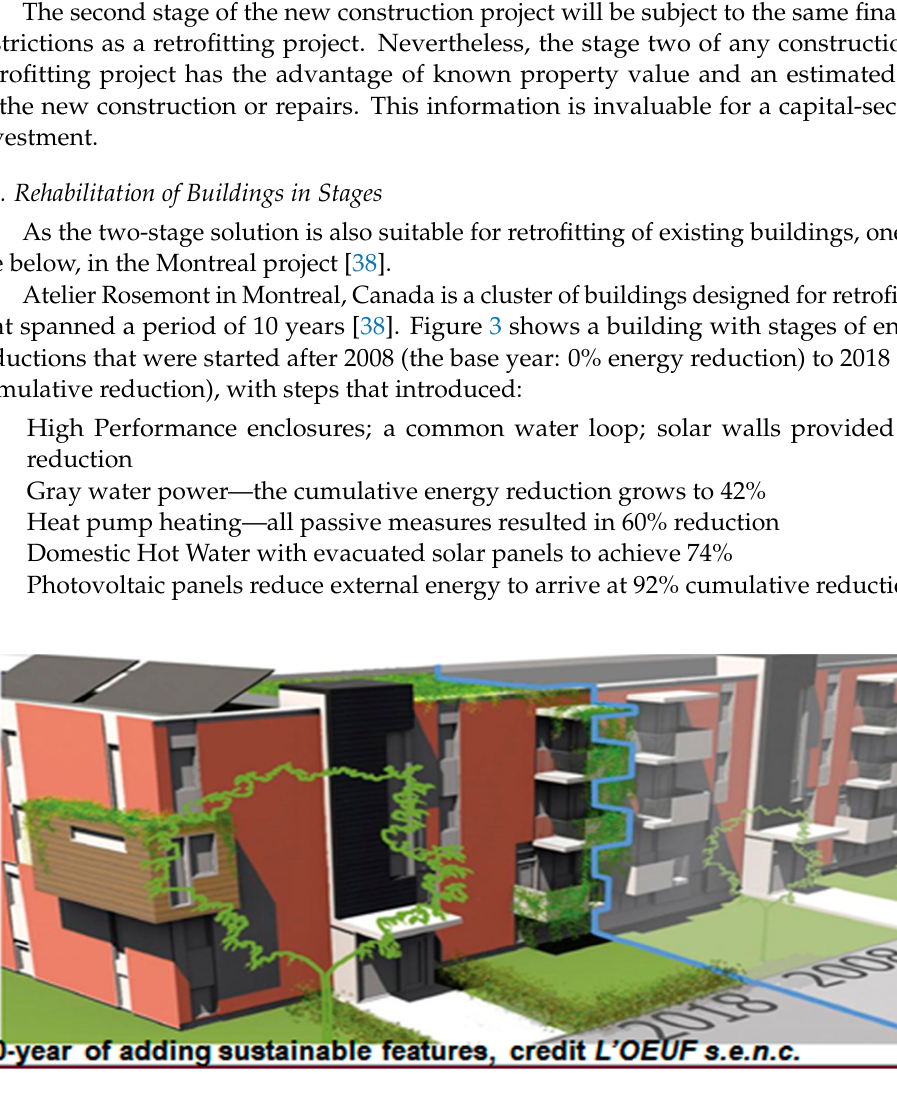
Figure 3. Stages of improvements from 2008 to 2018 in Atelier Rosemount, Montreal, (credit L’OeuF s.e.n.c., with permission).